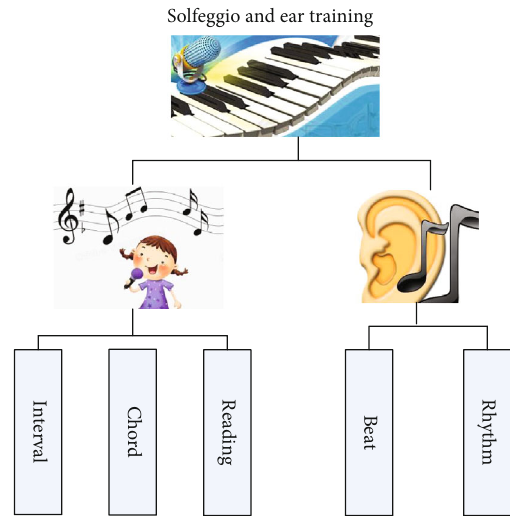
Figure 1: Schematic diagram of the structure of sight singing and ear